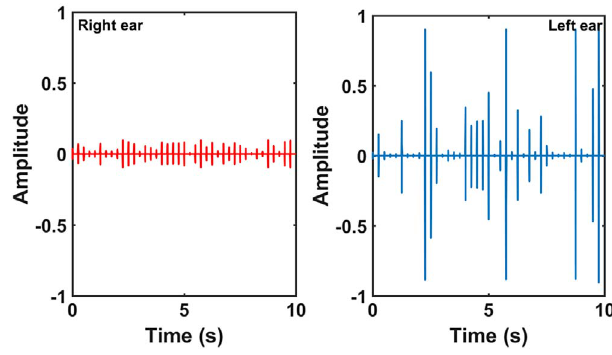
Figure 3. Normalised gamma fi lters for octave band frequen- cies between 250 Hz and 8 kHz.